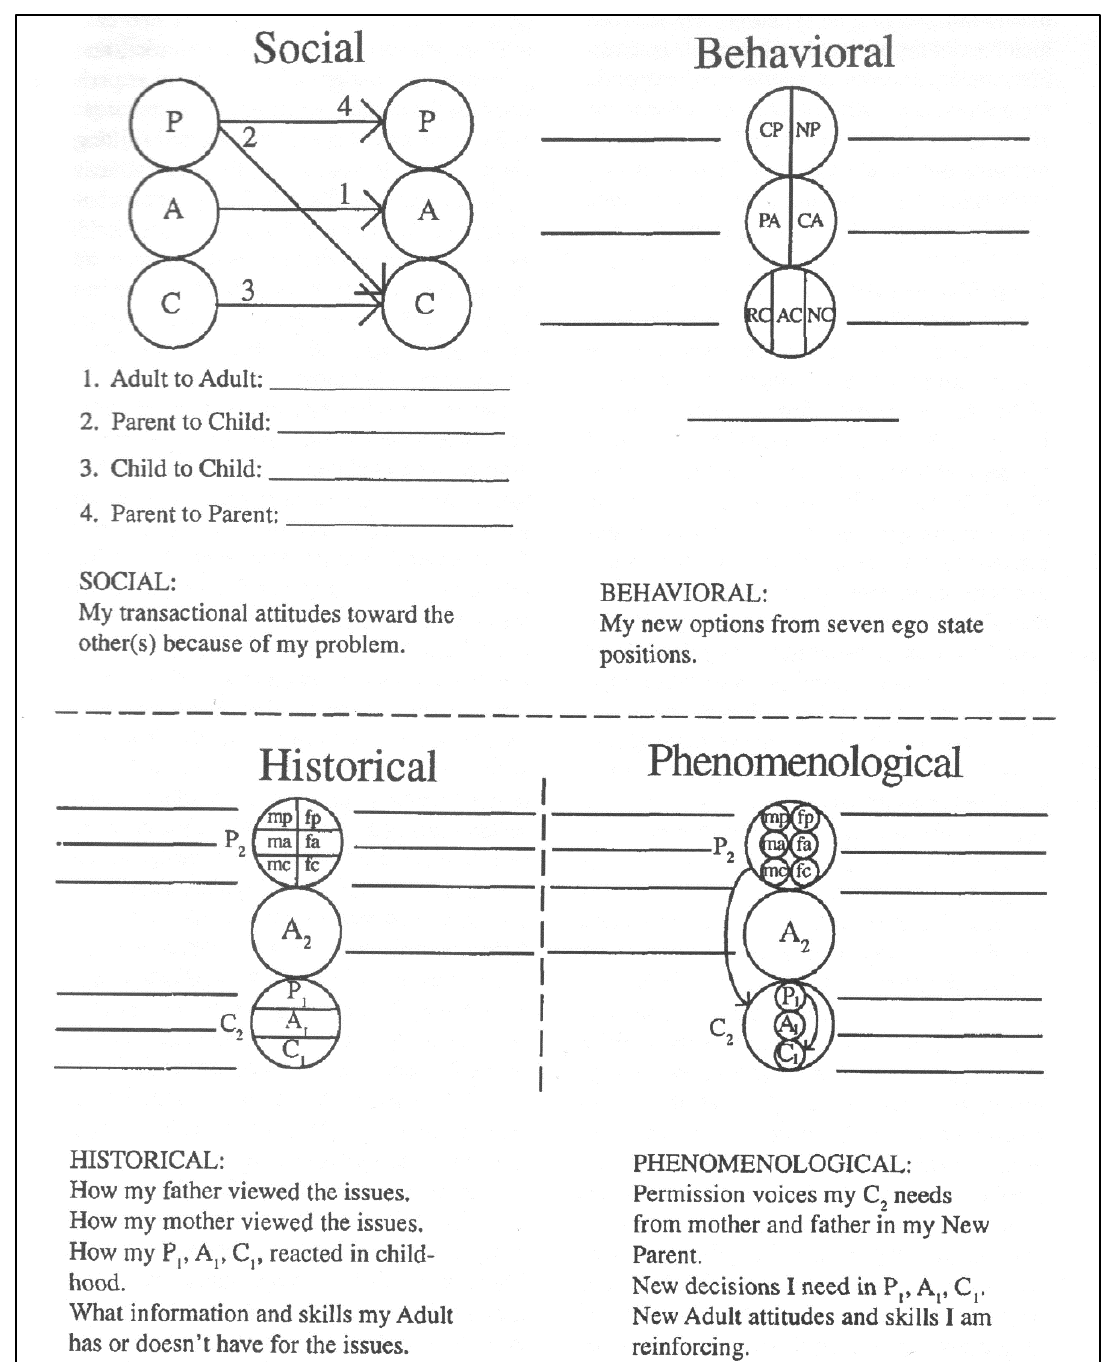
Figure 14: Ego State Models Worksheet for Problem Solving (Drego, 2000, p.200)